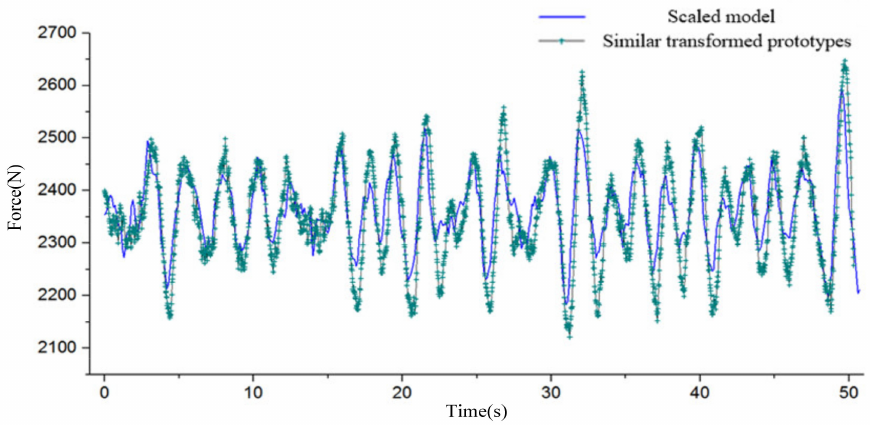
Figure 9. Force comparison diagram at the contact between tower and angle adjustment mechanism.